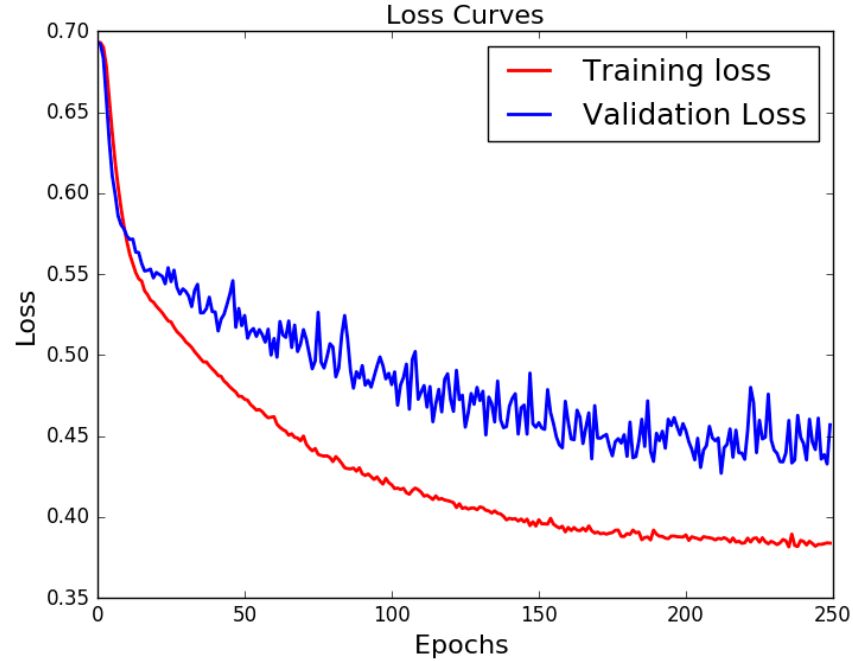
Figure 10. Overfitting and underfitting curves.